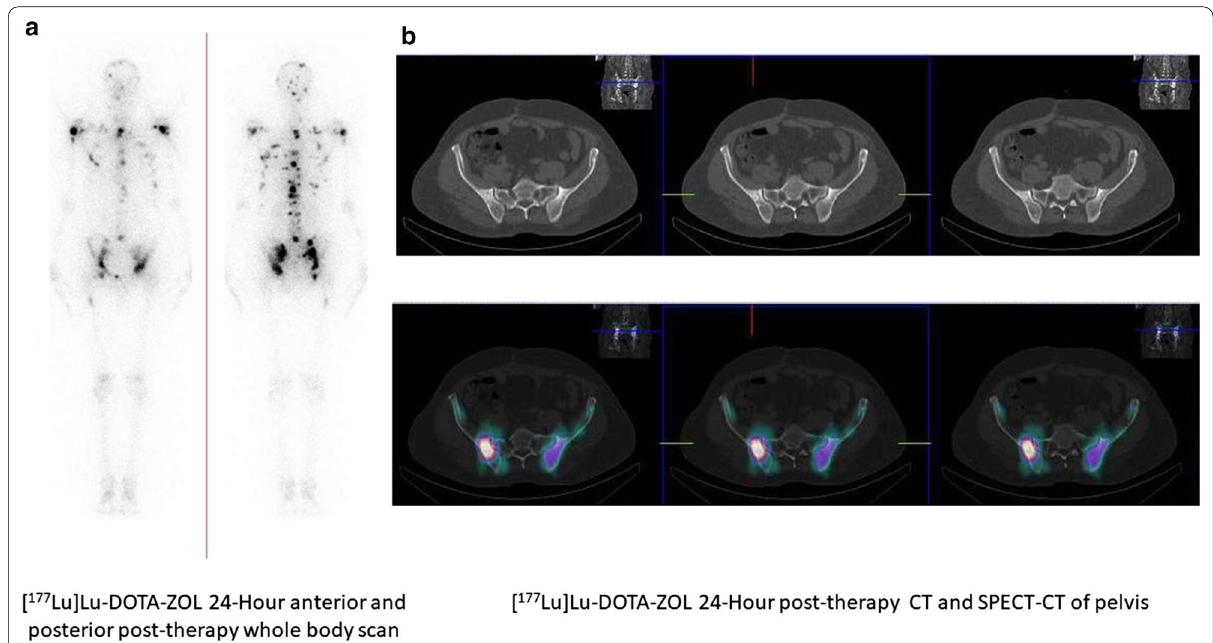
Fig. 1 A 55-year-old male diagnosed with prostatic adenocarcinoma underwent radical prostatectomy in April 2017, and his Gleason score was 3 4 7. He underwent hormonal therapy until April 2018 and received 1# of radiotherapy to B/L hip and D5-vertebra. He was referred to + = us for symptomatic pain relief. His baseline pain scoring (VASmax) was 9/10, with maximum pain in the B/L hips. We administered 1.3 GBq of [ 177 Lu]Lu-DOTA-ZOL and 24-h post-administration, a the 24-h anterior and posterior post-therapy whole-body scans demonstrating avid [ 177 Lu] Lu-DOTA-ZOL uptake in multiple skeletal sites. b The uptake of [ 177 Lu]Lu-DOTA-ZOL in the pelvic bone metastases on post-therapy